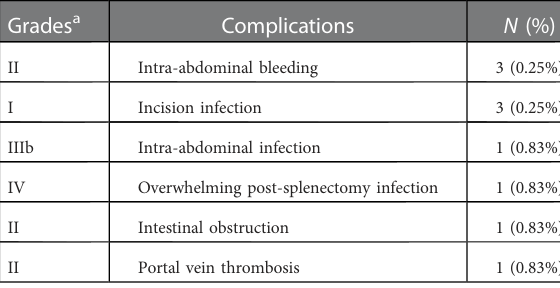
TABLE 4 Postoperative complications of